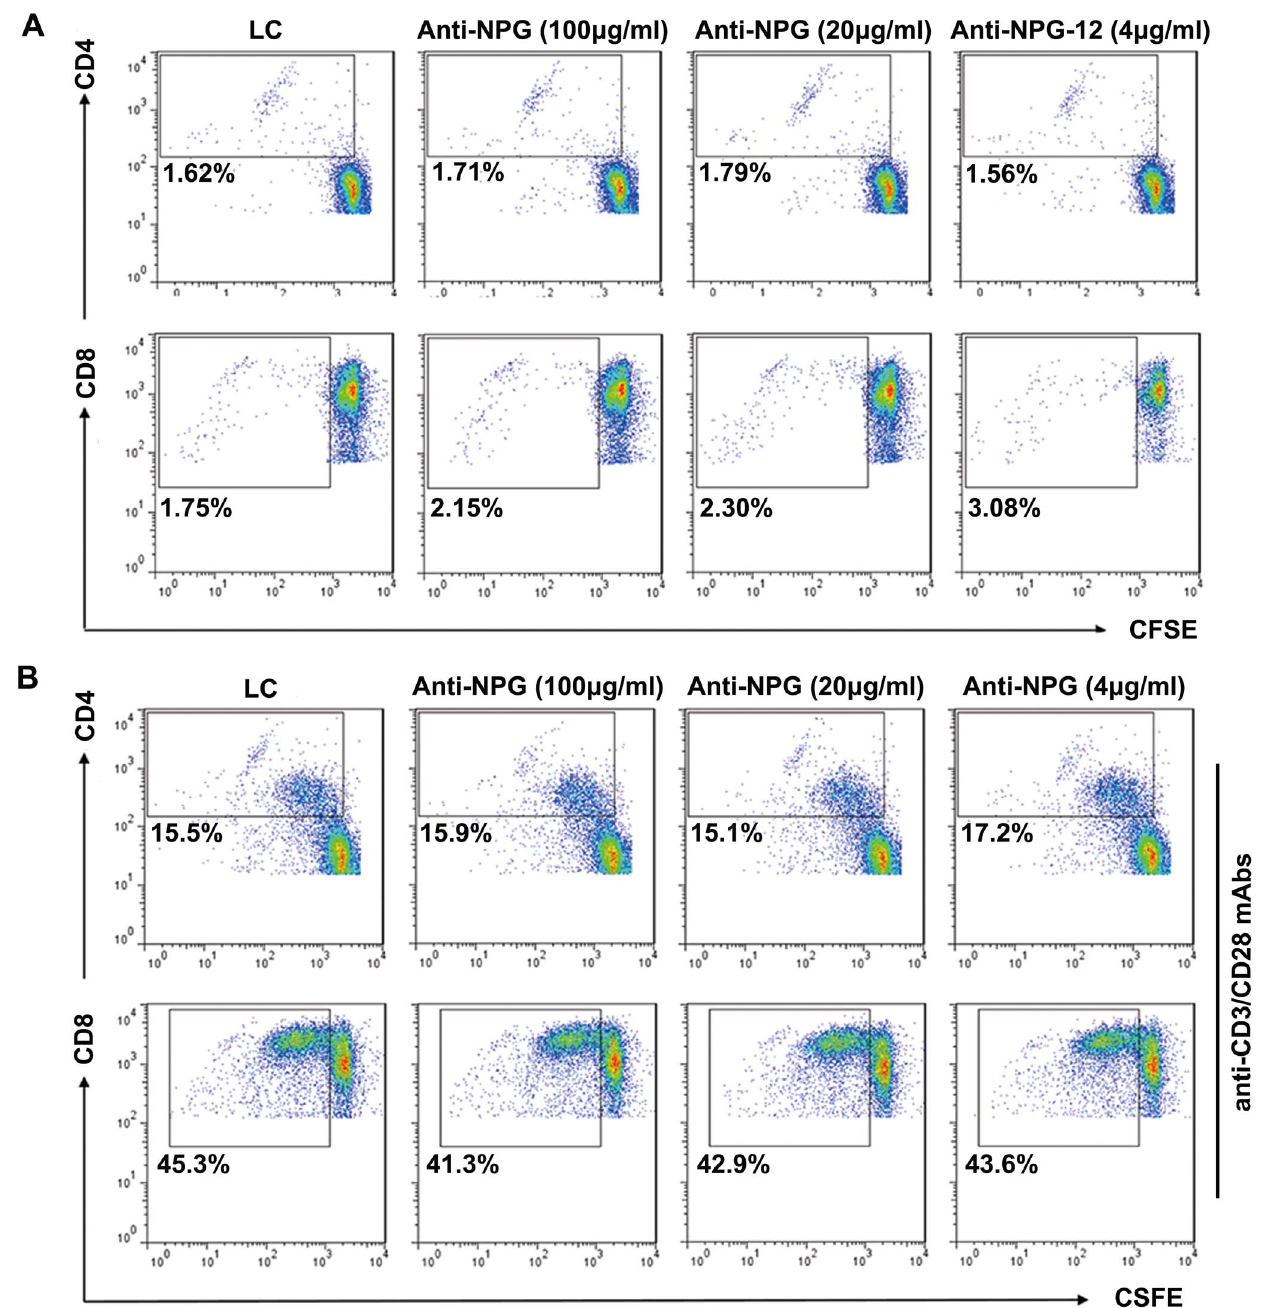
Figure 6. Anti-NPG-12 antibodies exhibited no influence on the proliferation of human peripheral blood T lymphocytes. (A) There was no significant difference in the CD4 + and CD8 + T lymphocyte proliferation in the absence of anti-CD3/CD28, as determined through FCM analysis ( P . 0.05). (B) There was no significant difference in the CD4 + and CD8 + T lymphocyte proliferation in the presence of anti-CD3/CD28, as determined through FCM analysis ( P .